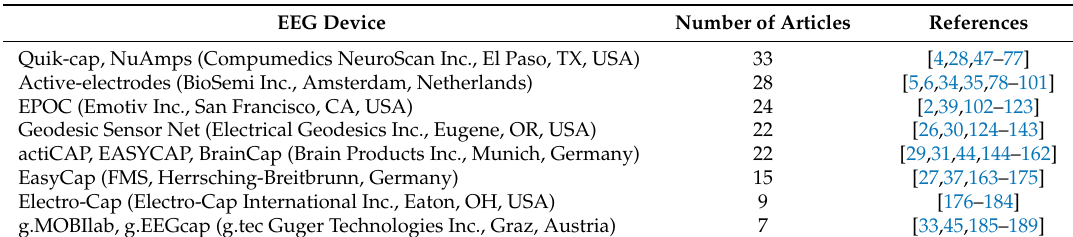
Table 3. Electroencephalography (EEG)